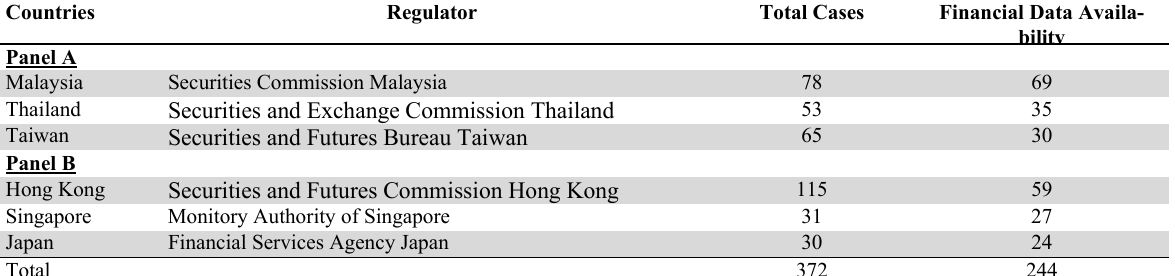
Distribution of